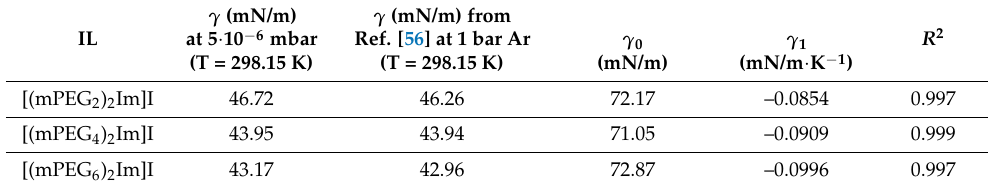
Figure 8. Surface tension values (see also Table S2 of SI) of the three degassed ILs [m(PEG n ) 2 Im]I (see inset) with n = 2, 4, 6 measured under vacuum (p = 5 · 10 − 6 mbar) for different temperatures; symbol heights correspond to measurement error; crosses at 298.15 K (dashed line) represent the values given in Table 3 based on the linear fits according to Equation (1). Table 3. Surface tension values of [(mPEG n ) 2 Im]I with n = 2, 4, 6 at T = 298.15 K measured under vacuum in comparison to literature data measured under 1 bar Ar atmosphere [56]. Coefficients γ 0 and γ 1 of Equation (1) for the temperature-dependent surface tension are also given along the R 2 values of the linear